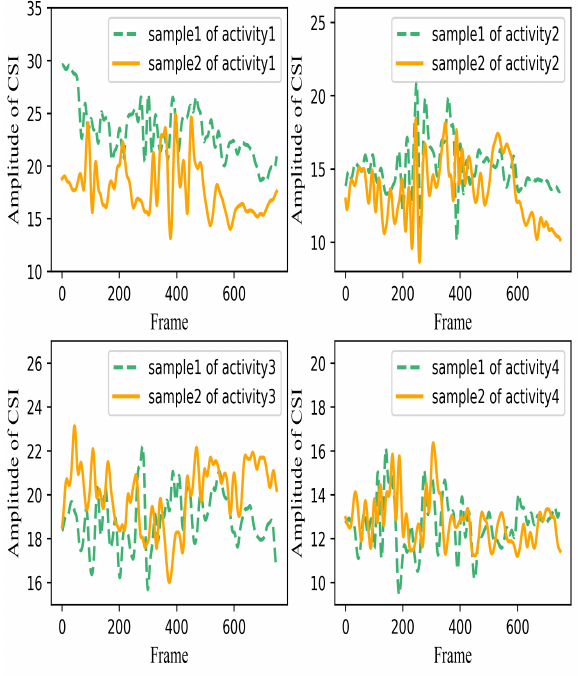
Figure 1. CSI amplitude of four different activities at the same